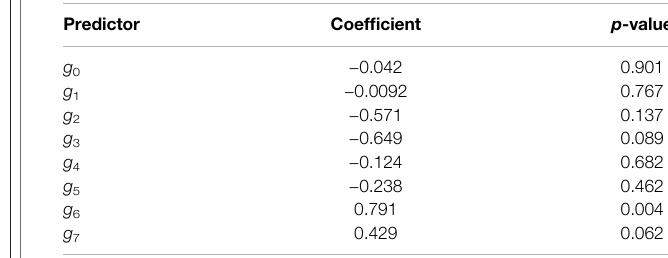
TABLE 5 | The GLM regression model parameter estimates and p -values for the indicator